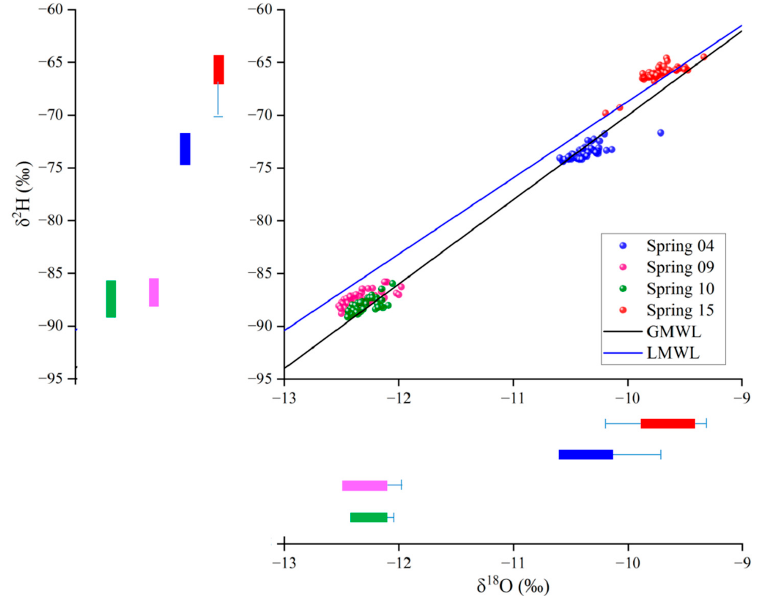
Figure 7. Bivariant δ 2 H– δ 18 O plot for samples from Spring 04 (blue circles), Spring 15 (red circles), Spring 09 (pink circles), and Spring 10 (green circles). The global meteoric water line (GMWL of Craig [42]) is shown by the black line and indicates meteoric water affected by water–rock interaction. The local meteoric water line (LMWL of Feng et al. [43]) is shown by the blue